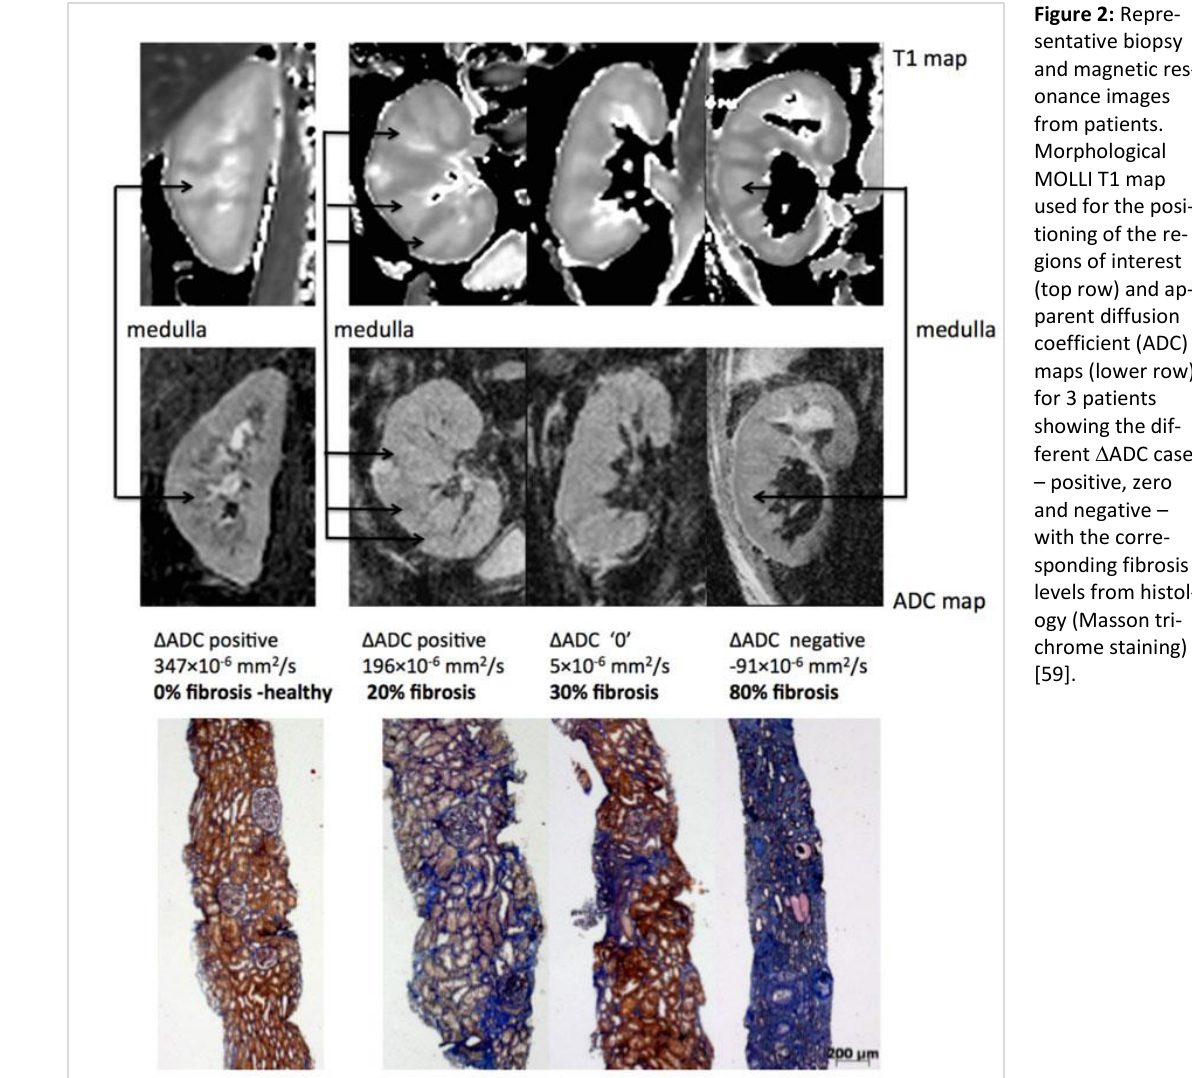
Figure 2: Repre- sentative biopsy and magnetic res- onance images from patients. Morphological MOLLI T1 map used for the posi- tioning of the re- gions of interest (top row) and ap- parent diffusion coefficient (ADC) for 3 patients showing the